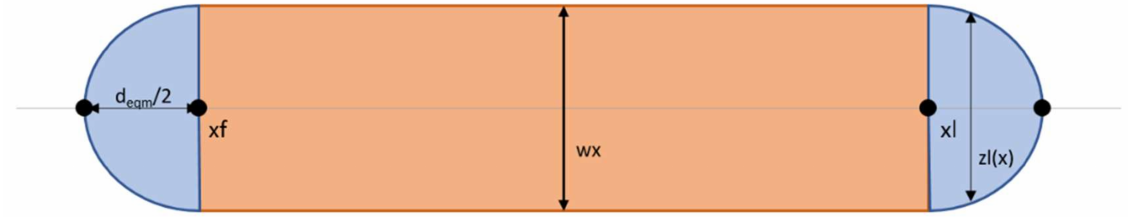
Figure 9. Base shape of a modelled drop line.